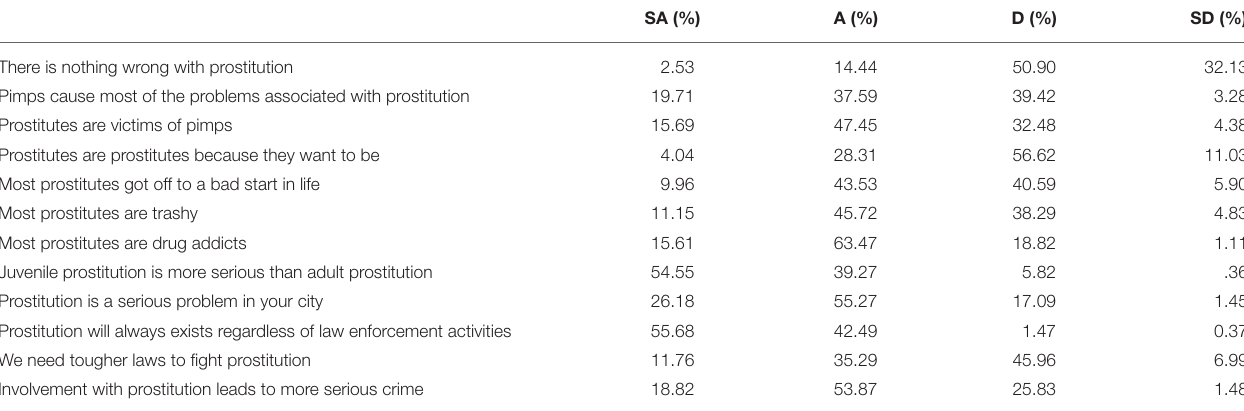
TABLE 2 | Descriptive statistics for prostitution-related items.